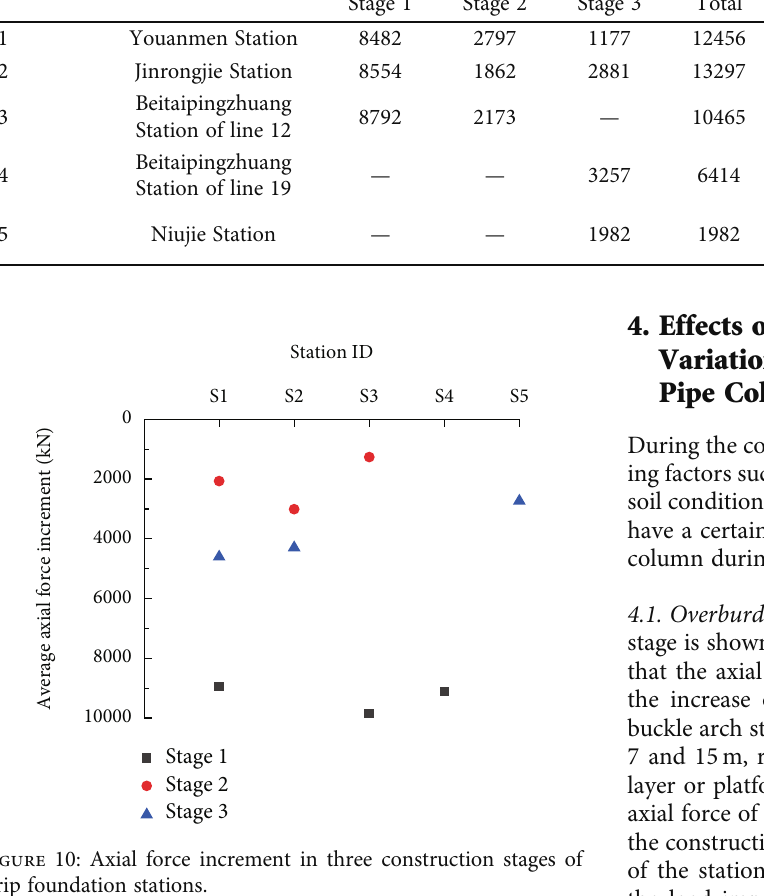
Table 3: Axial forces increment of steel pipe columns in di ff erent construction stages of the pile foundation stations (unit: kN). Station ID